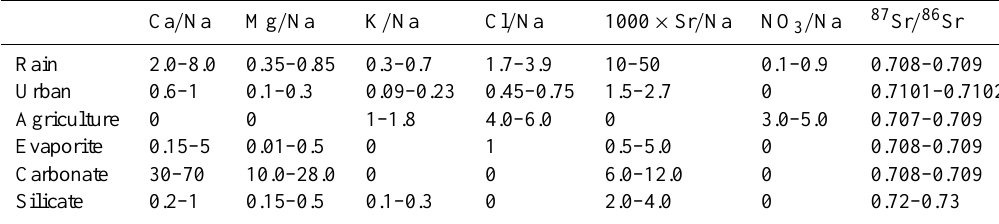
Table 6. The estimated end member values in the Xishui River.